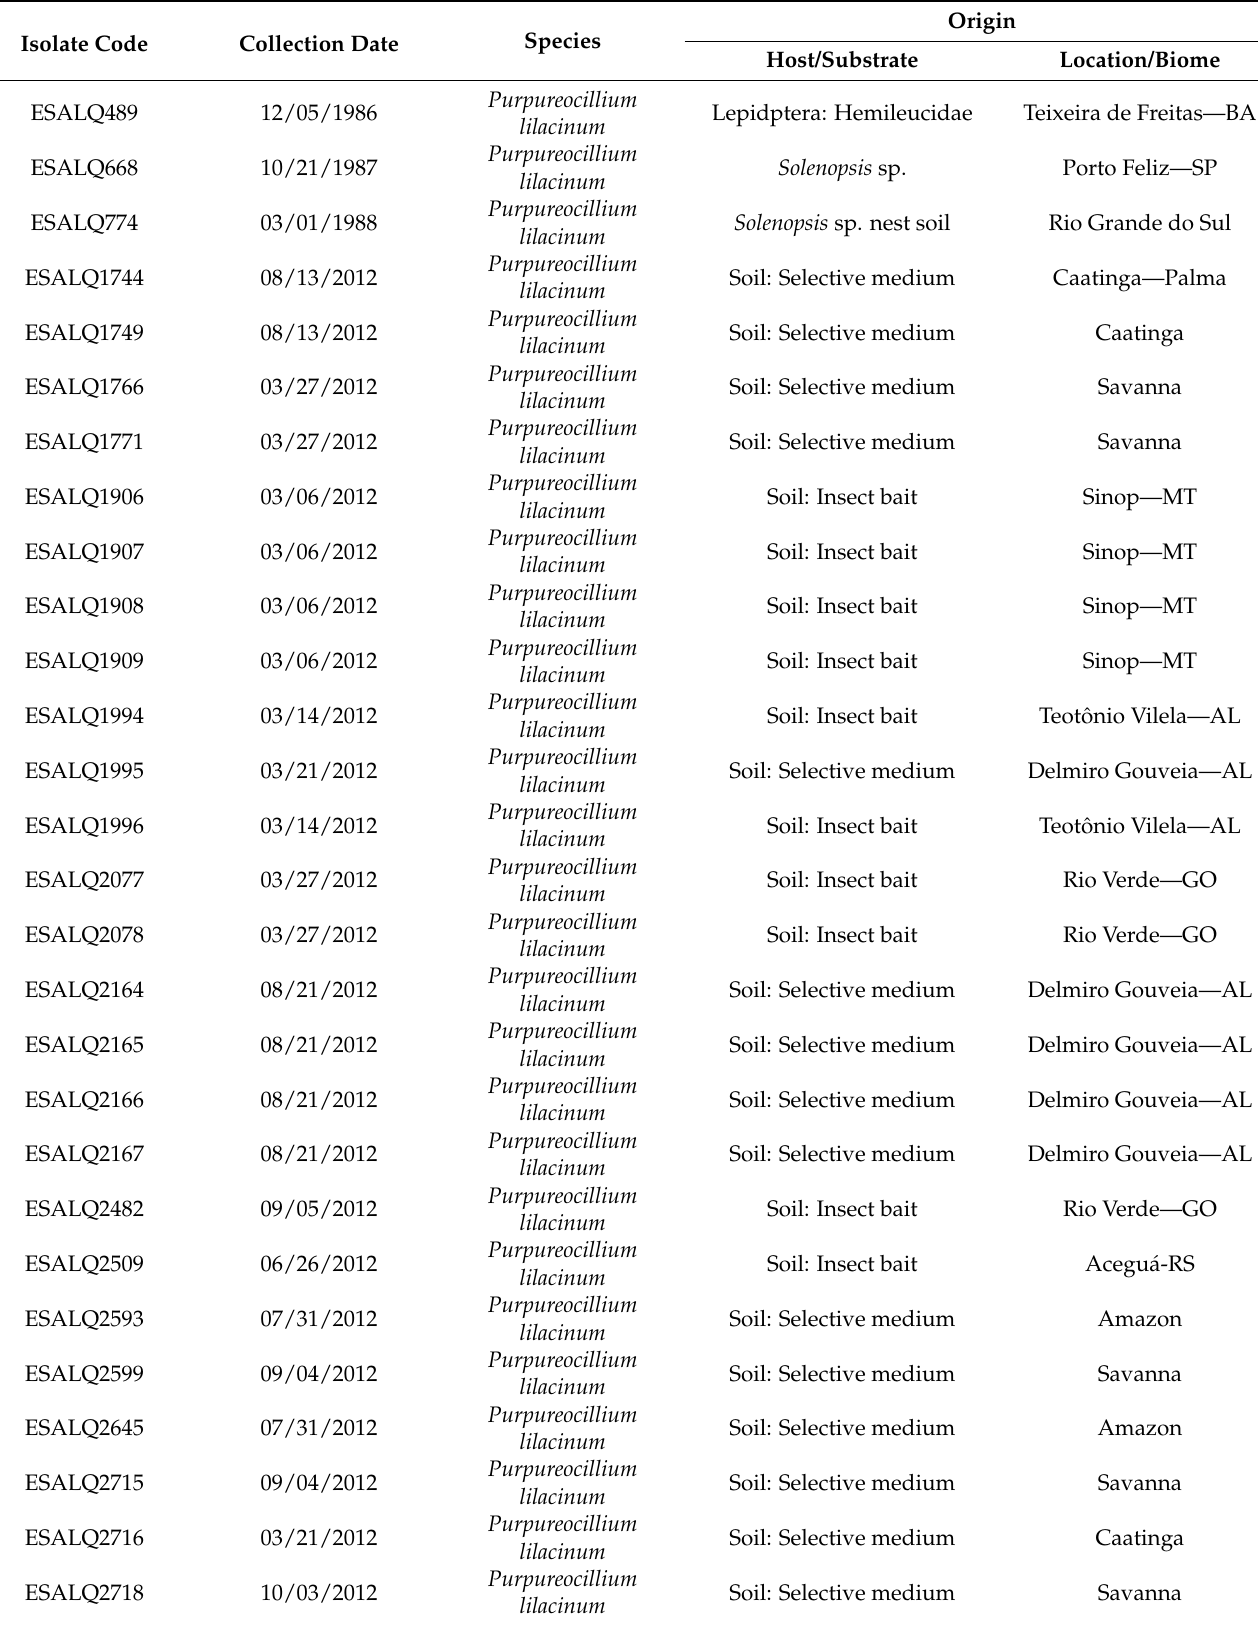
Table 1. Description of the origin and collection date of Purpureocillium lilacinum and Pochonia chlamydosporia isolates used in the